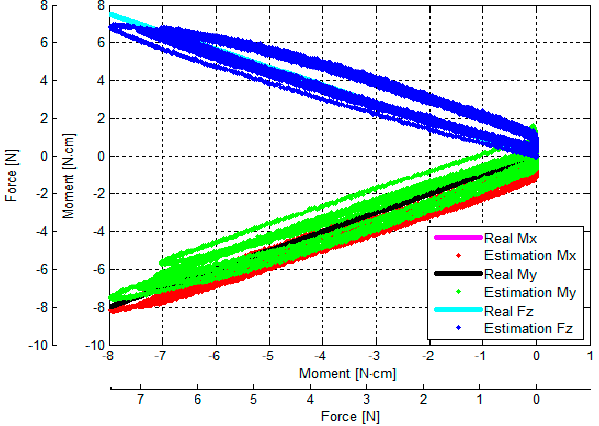
Figure 19. Comparison between real ( F z , M x , M y ) values and estimated ( F z , M x , M y ): external force was applied to and released from point ⑧ obtained by the sensor calibration device as shown in Figure 12.